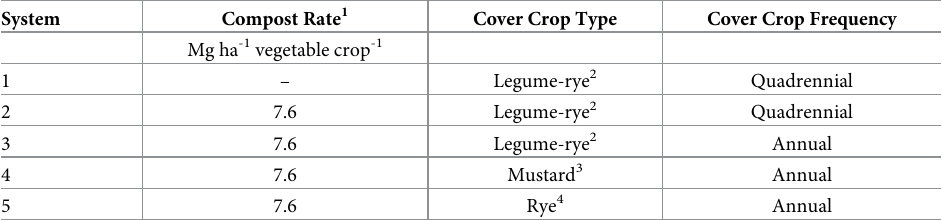
Table 1. The five systems at the Salinas Organic Cropping Systems (SOCS) experiment evaluated in this analysis. System Compost Rate